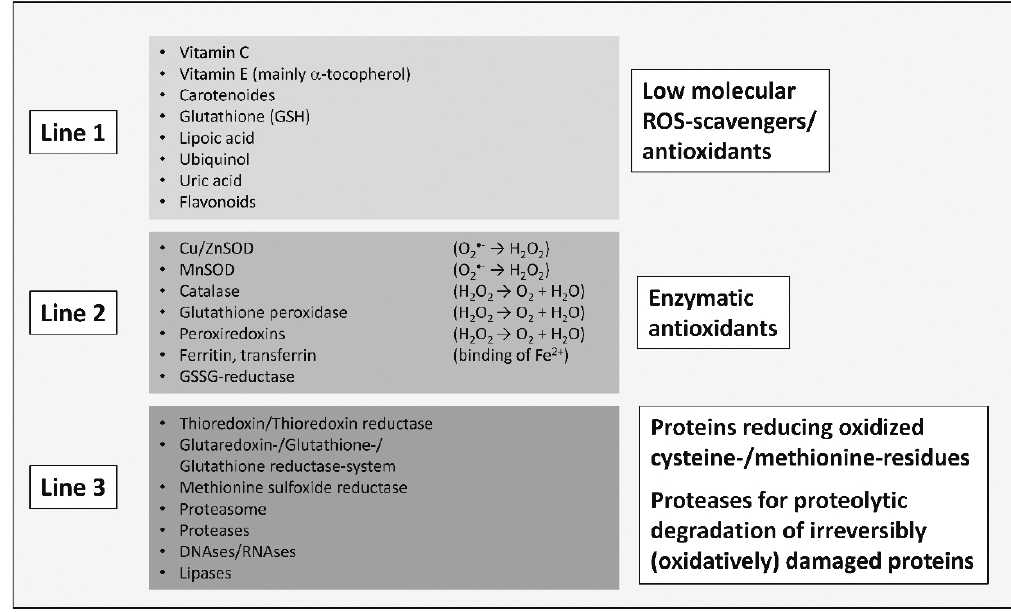
Figure 1. “Three lines of antioxidative defense” in mammalian cells, modified according to [5]. The first line contains low molecular antioxidants that can scavenge ROS/reactive particles in a purely competitive way, preventing damage from cellular structures like proteins, nucleobases and lipids. The reaction products are mostly significantly less reactive and may in several cases be restored by cellular systems (like vitamin C and tocopherol in a glutathione (GSH)-consuming manner). The most important and abundant low molecular